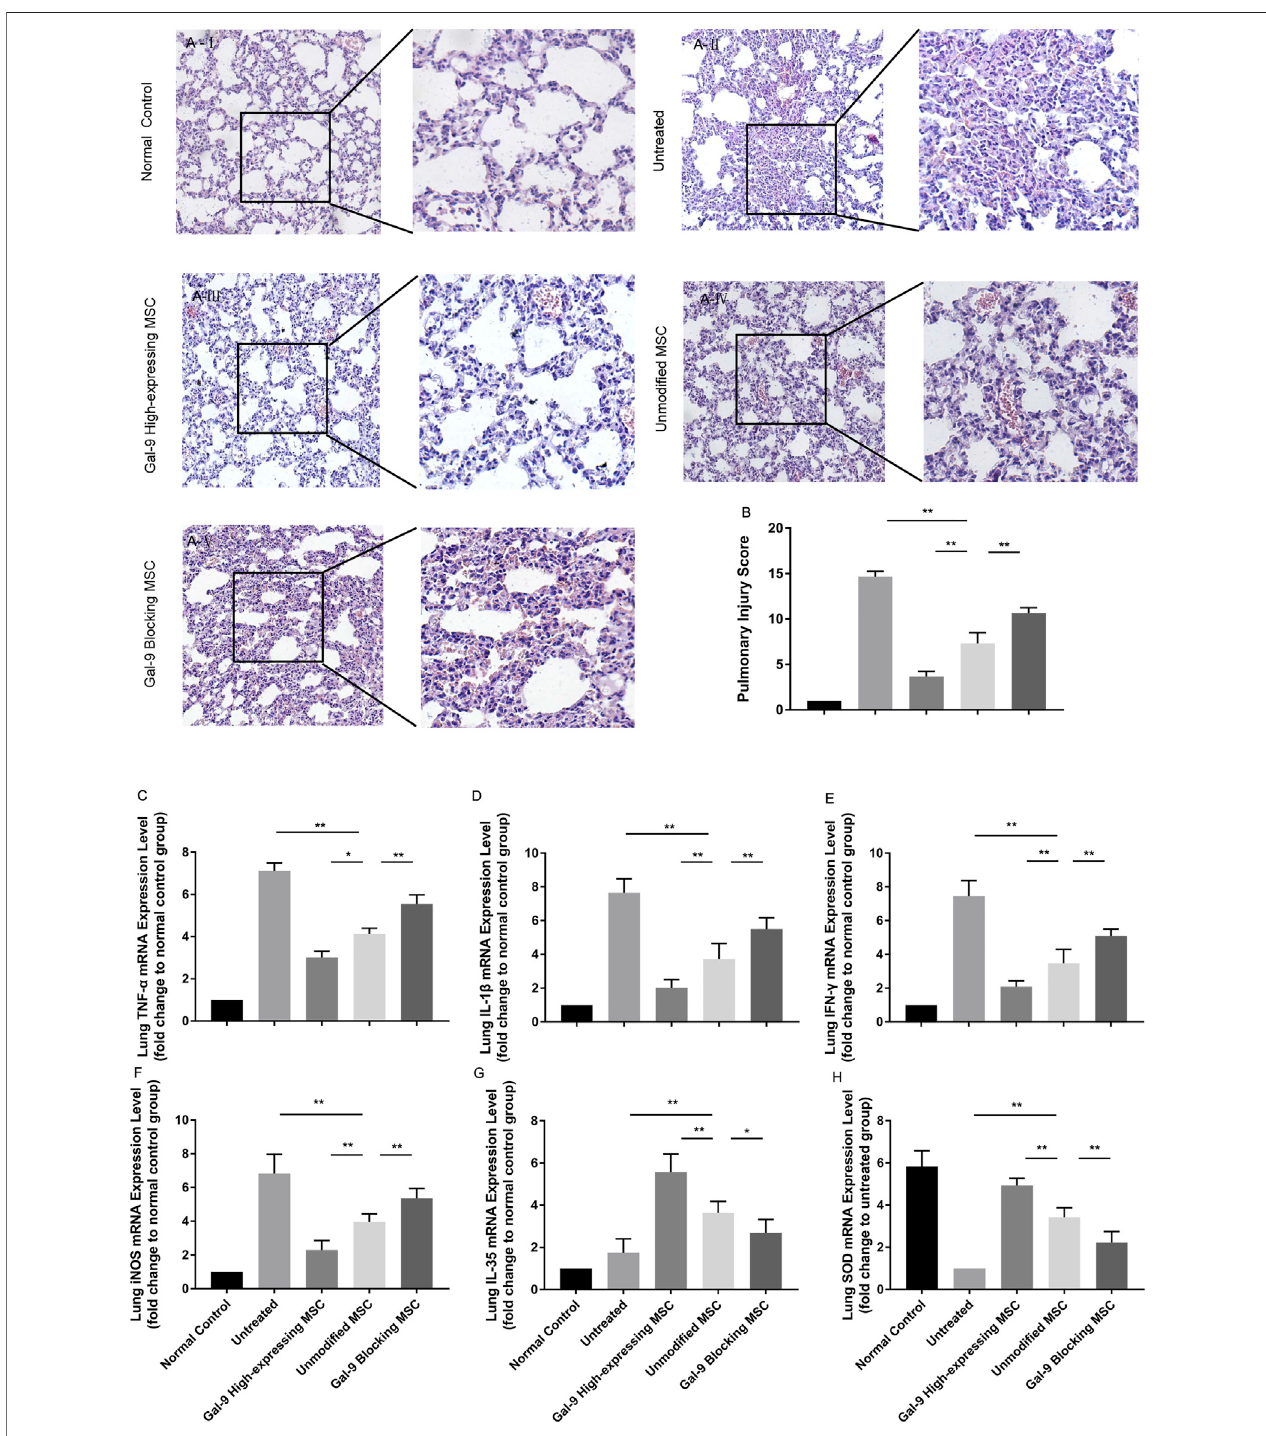
FIGURE 5 | Gal-9 mediates MSC-based therapy in alleviating pulmonary injury. (A) Representative histological sections of mouse lung in each group (H&E, 100 × magni fi cation) and a selected small square area were magni fi cently displayed on the right side (200 × magni fi cation). (B) Pulmonary injury score. Criteria for evaluating lung injury were as follows: edema, alveolar and interstitial in fl ammation, alveolar and interstitial hemorrhage, and necrosis (0 − 4, total: 0 – 16). (C – H) mRNA expression levelsofTNF- α (C) ;IL-1 β (D) ;IFN- γ (E) ;iNOS (F) ;EBI3 (IL-35) (G) ;SOD (H) .Datavariance wasassessed byusingone-wayanalysisofvariance(ANOVA),followed byleast signi fi cantdifference(LSD)test, n =6.* p < 0.05,** p < 0.01. Abbreviations:EBI3,Epstein-Barr virus-induced gene3;iNOS, induciblenitric oxidesynthase; SOD, superoxide dismutase.